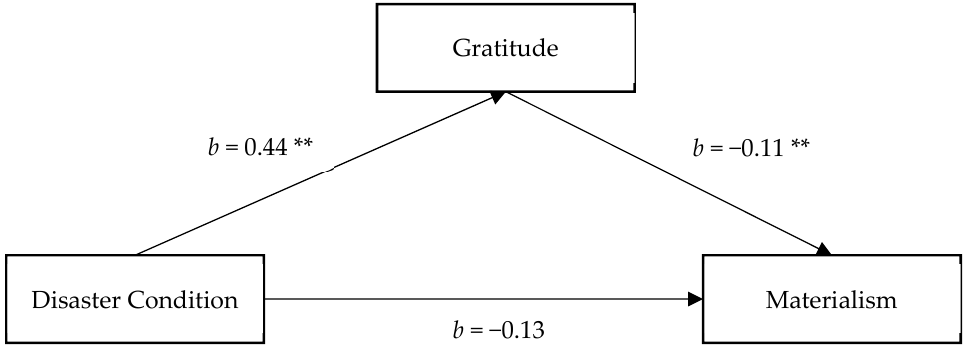
Figure 2. Gratitude as mediator of the relationship between condition and materialism. Note: Reported values are unstandardized regression coefficients and standardized indirect effects with bootstrapped 95% confidence interval, ** p < 0.01.